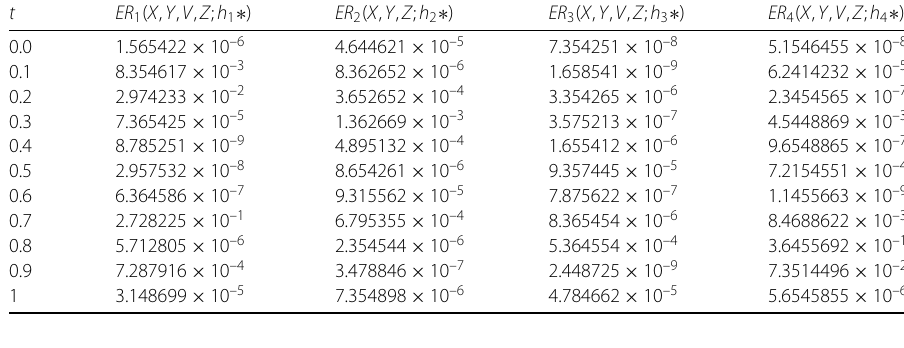
Table 4 The residual errors for ER 1 , ER 2 , ER 3 and ER 4 for t ∈